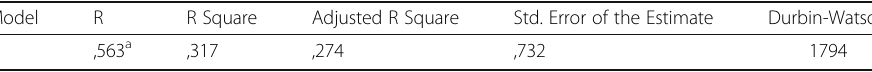
Table 15 Model Summary R1 b Model R R Square Adjusted R Square Std. Error of the Estimate Durbin-Watson ,563 a ,317 ,274 ,732